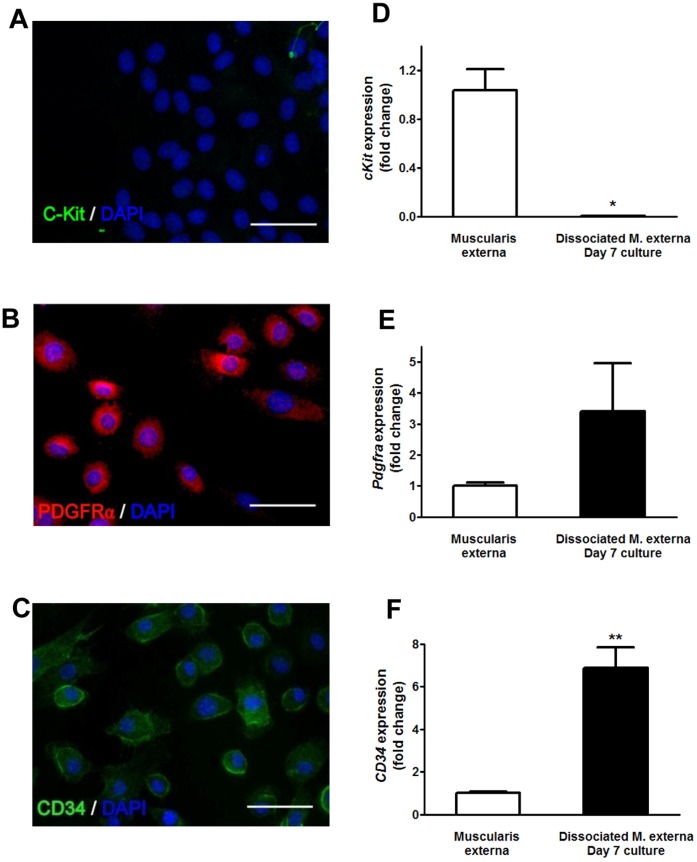
GPR39 expressing cells are fibroblast-like cells.(A-C) Representative images for immuno-labelling of C-Kit, CD34, PDGFRα and SK3 in cultured cobblestone-like cells. Scale bar = 50 µm. (D-F) the mRNA expression levels of CD34 and pdgfra in the cultures increased 6.87±0.96 (p<0.01) and 3.39±1.55 (p>0.05) fold respectively, while c-kit expression decreased 0.0013±0.0003 (p<0.05) fold.